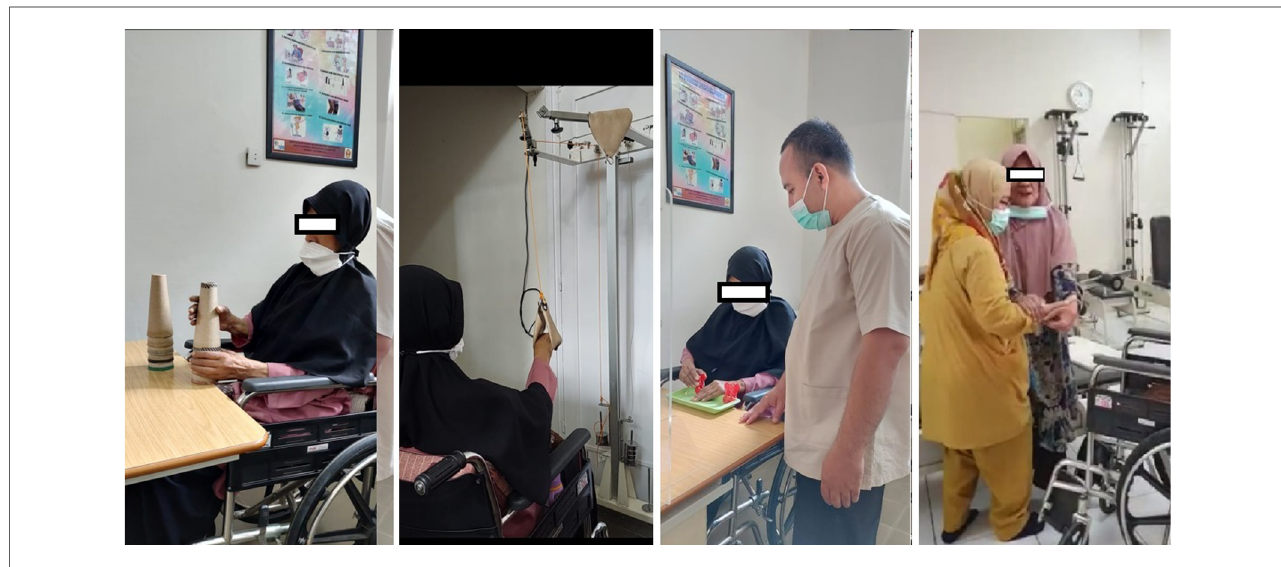
FIGURE 2 PRM program was given to our